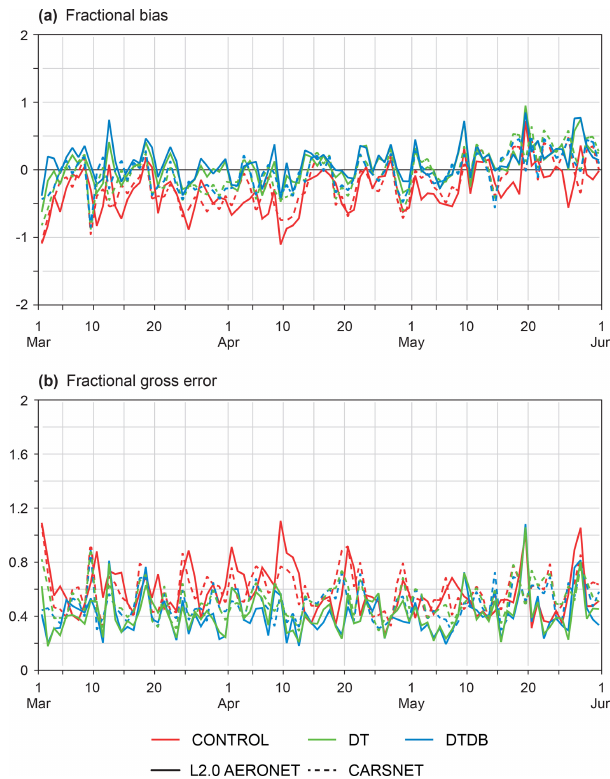
Figure 6. Time series of fractional bias (a) and fractional gross error (b) in AOD at 440nm averaged over the central–northern China area (33 sites). Solid lines are relative to AERONET data, whereas dotted lines are relative to CARSNET data. Red is exper- iment CONTROL, green is experiment DT and blue is experiment